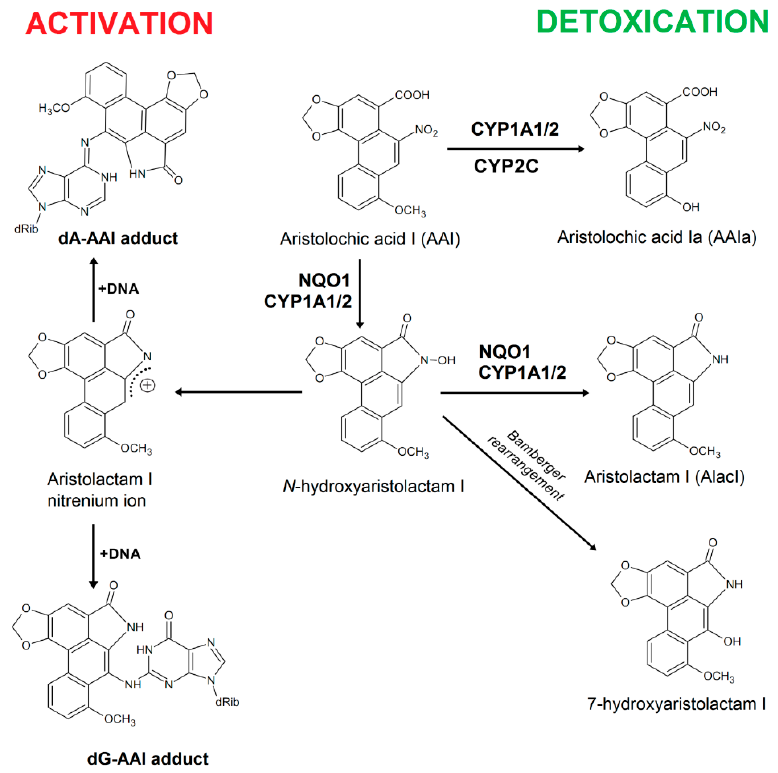
Figure 1. Activation and detoxification pathways of AAI. dA-AAI, 7-(deoxyadenosin- N 6 -yl)aristolactam I; dG-AAI, 7-(deoxyguanosin- N 2 -yl)aristolactam I; CYP1A1/2, cytochrome P450 1A1 and 1A2; CYP2C, cytochromes P450 of the 2C subfamily; and NQO1, NAD(P)H:quinone oxidoreductase. In contrast to the findings that AAI might directly cause interstitial nephropathy, enzymatic activation of AAI to intermediates that bind to DNA is a necessary reaction leading to AA-mediated malignant transformation [8,9,11–15]. Indeed, exposure to AA has been proven by the detection of unique DNA adducts formed by AA in many tissues of patients suffering from AAN and BEN [9,10,16–18]. Specific AA-DNA adducts found in kidneys of patients are considered as biomarkers of exposure to AA; among them the 7-(deoxyadenosin- N 6 -yl)aristolactam I (dA-AAI) adduct is formed most frequently and is the long persistent adduct [1,5,10,18,19]. This DNA lesion produces specific A to T transversion mutations that were detected in the TP53 tumor suppressor gene in tumors of patients suffering from AAN and BEN [8,9,20] and in immortalized Hupki (human TP53 knock-in) mouse fibroblast cells (HUFs) treated with AAI [21], suggesting a molecular mechanism of AA-induced carcinogenic processes [8,22]. Interestingly, these A to T transversions have also been